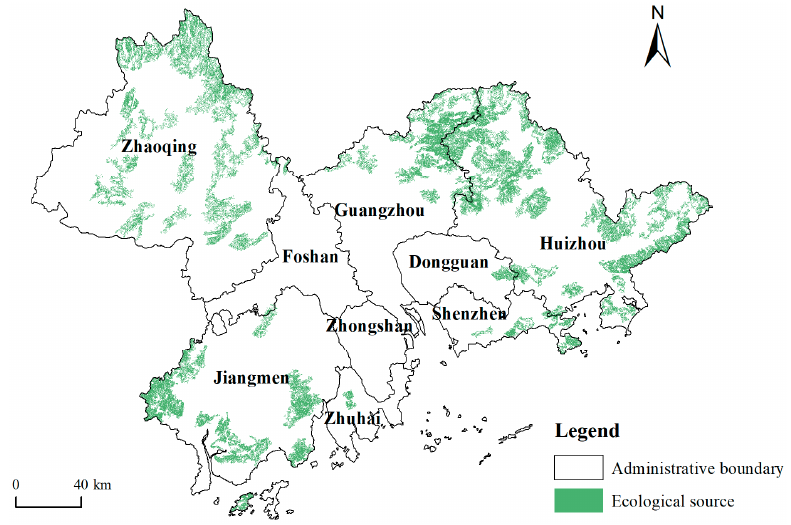
Figure 5. Spatial distribution of ecological sources.